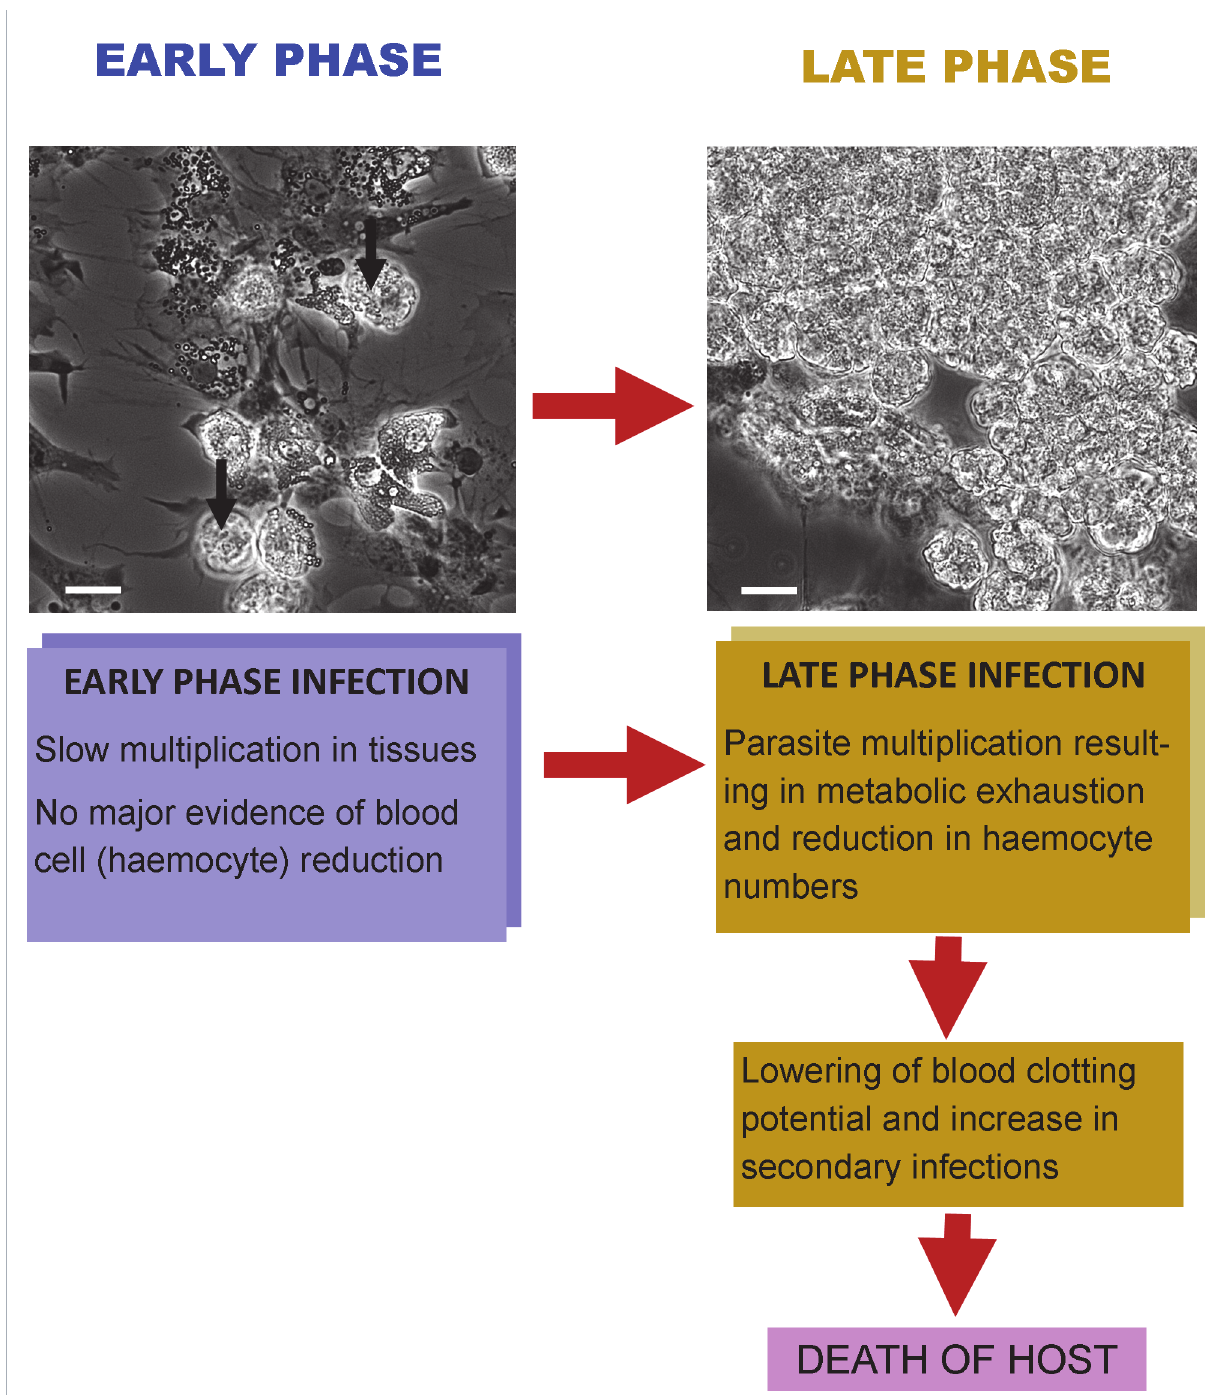
Fig 1. Interaction of Hematodinium with its crustacean host. At an early phase of infection there is a small number of parasites in the haemolymph (unlabelled arrows) and a large number of haemocytes in circulation, as found in uninfected individuals (spread cells in micrograph). In late-phase infections, there are often large masses of Hematodinium in the haemolymph and very few circulating haemocytes. This reduction in haemocytes results in an increased likelihood of secondary infections and prolonged bleeding times following wounding. Death probably ensues as a result of parasite development and utilisation of host ’ s metabolic products, as well as a heightened chance of secondary